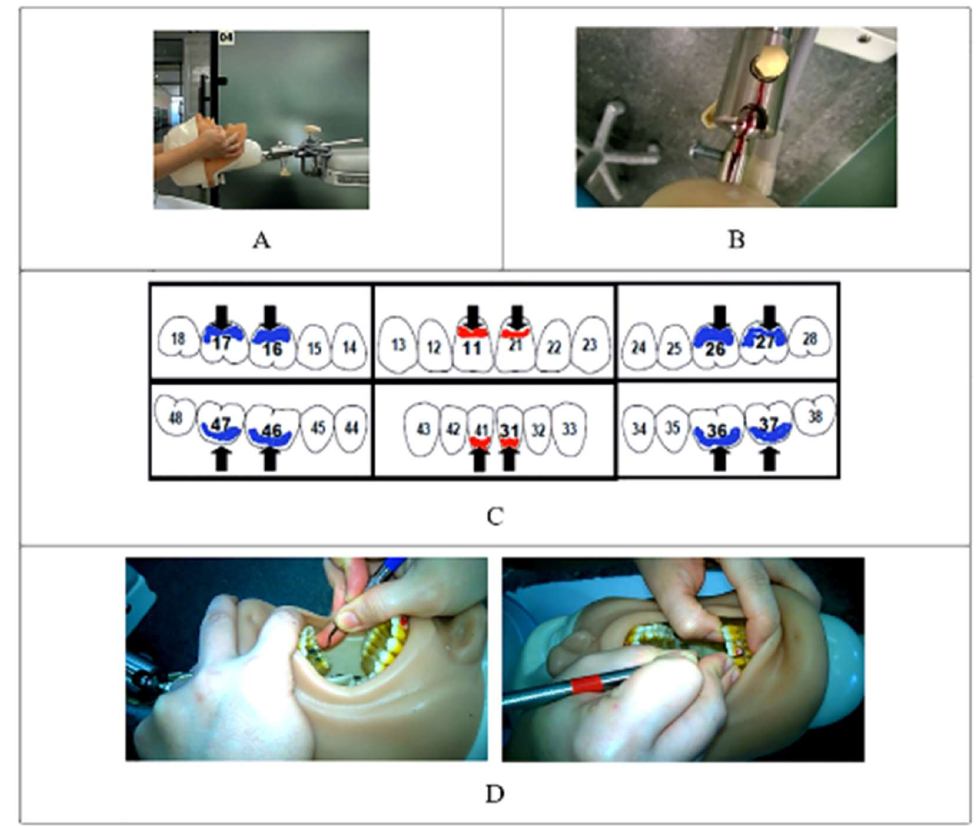
Figure 2. Attachment of the phantom head to the patient’s dental chair and organization of the dental procedure. ( A ) Phantom head attachment to the patient’s dental chair; ( B ) Control of the phantom head motion by means of boundary lines; ( C ) Dental surfaces to be cleaned; ( D ) Identification of anterior and posterior curettes by means of colors.